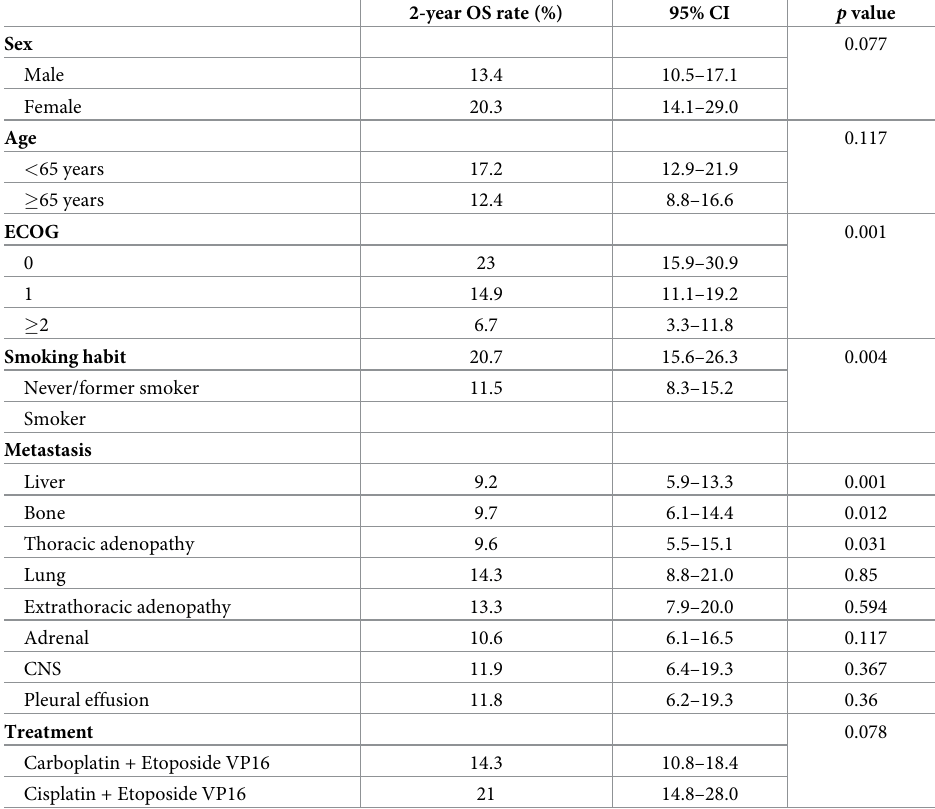
Table 4. Multivariate analysis of 2-year OS rates according to patient